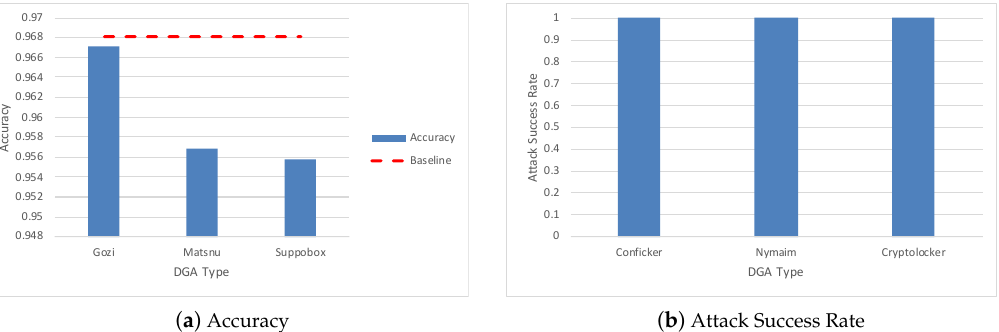
Figure 6. ( a ) The BA of IDN-trigger backdoor attack based on different DGAs and ( b ) the ASR of IDN-trigger backdoor attack based on different DGAs.